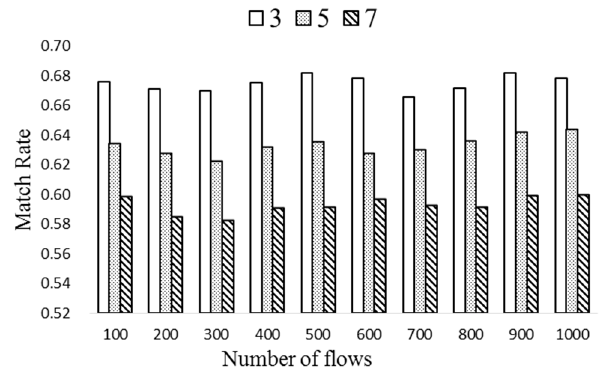
Figure 11. The match rates with different n t .